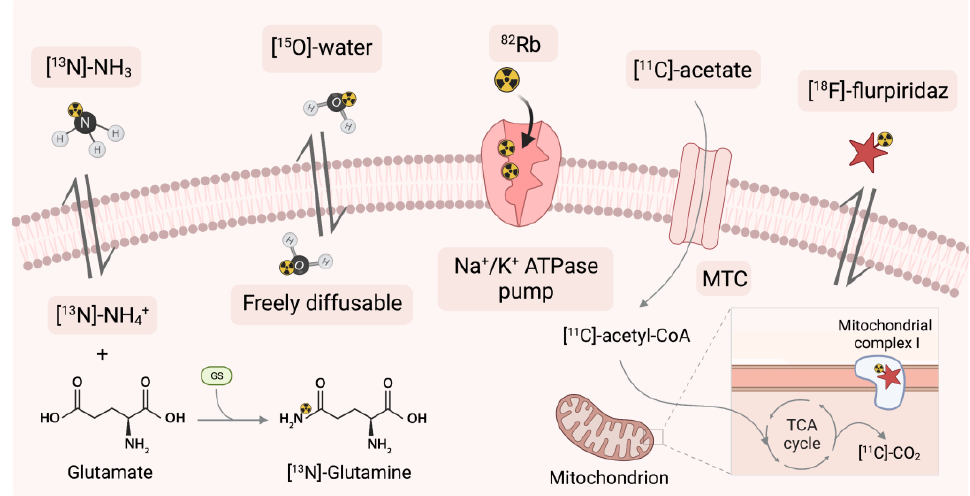
Figure 5. Mechanisms of action of perfusion PET tracers. [ 13 N]-NH 3 = [ 13 N]-ammonia, MTC = monocarboxylate transporter, [ 18 F]-flurpiridaz = 4-Chloro-5-[(4-{[2-[ 18 F]fluoroethoxy]methyl}benzyl)oxy]-2-(2-methyl-2-propanyl)-3(2H)-pyridazinone, TAC = the tricarboxylic acid cycle.